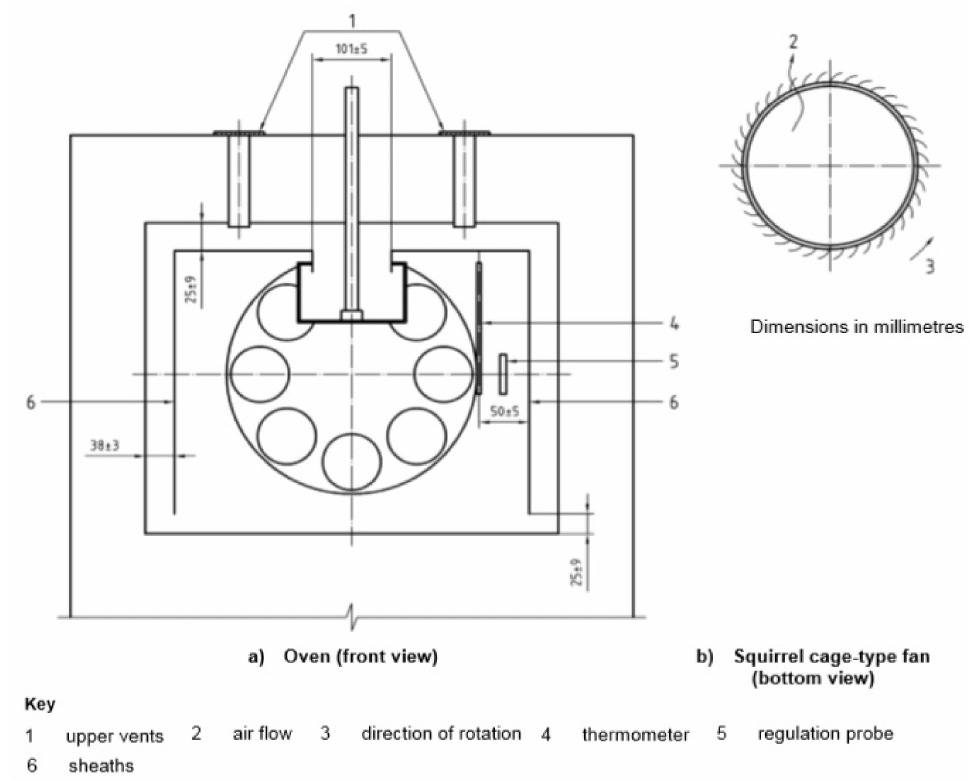
Figure 5. Oven and squirrel cage-type fan for aging by the RTFOT method (EN